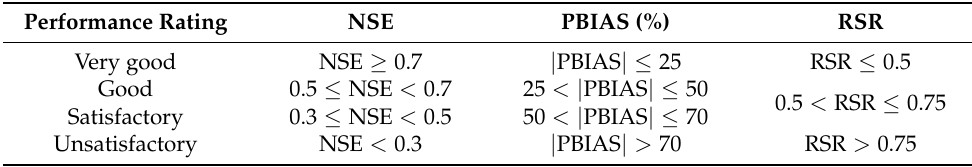
Table 1. Model performance evaluation criteria.